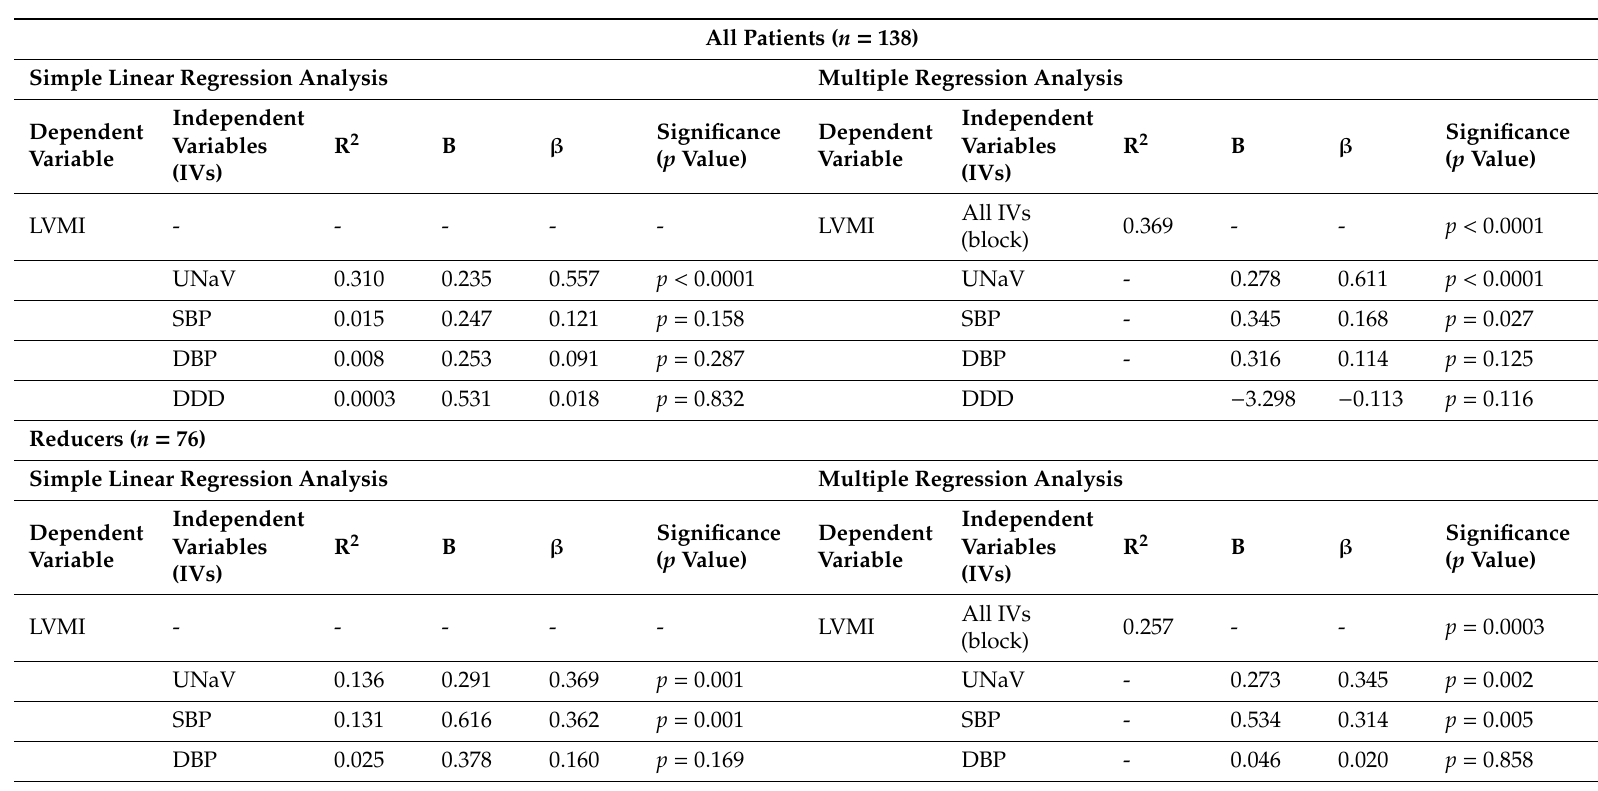
Table 3. Simple and multiple linear regression analysis evaluating the impact of sodium excretion, blood pressure and drug consumption on left ventricular mass index at study end (Time